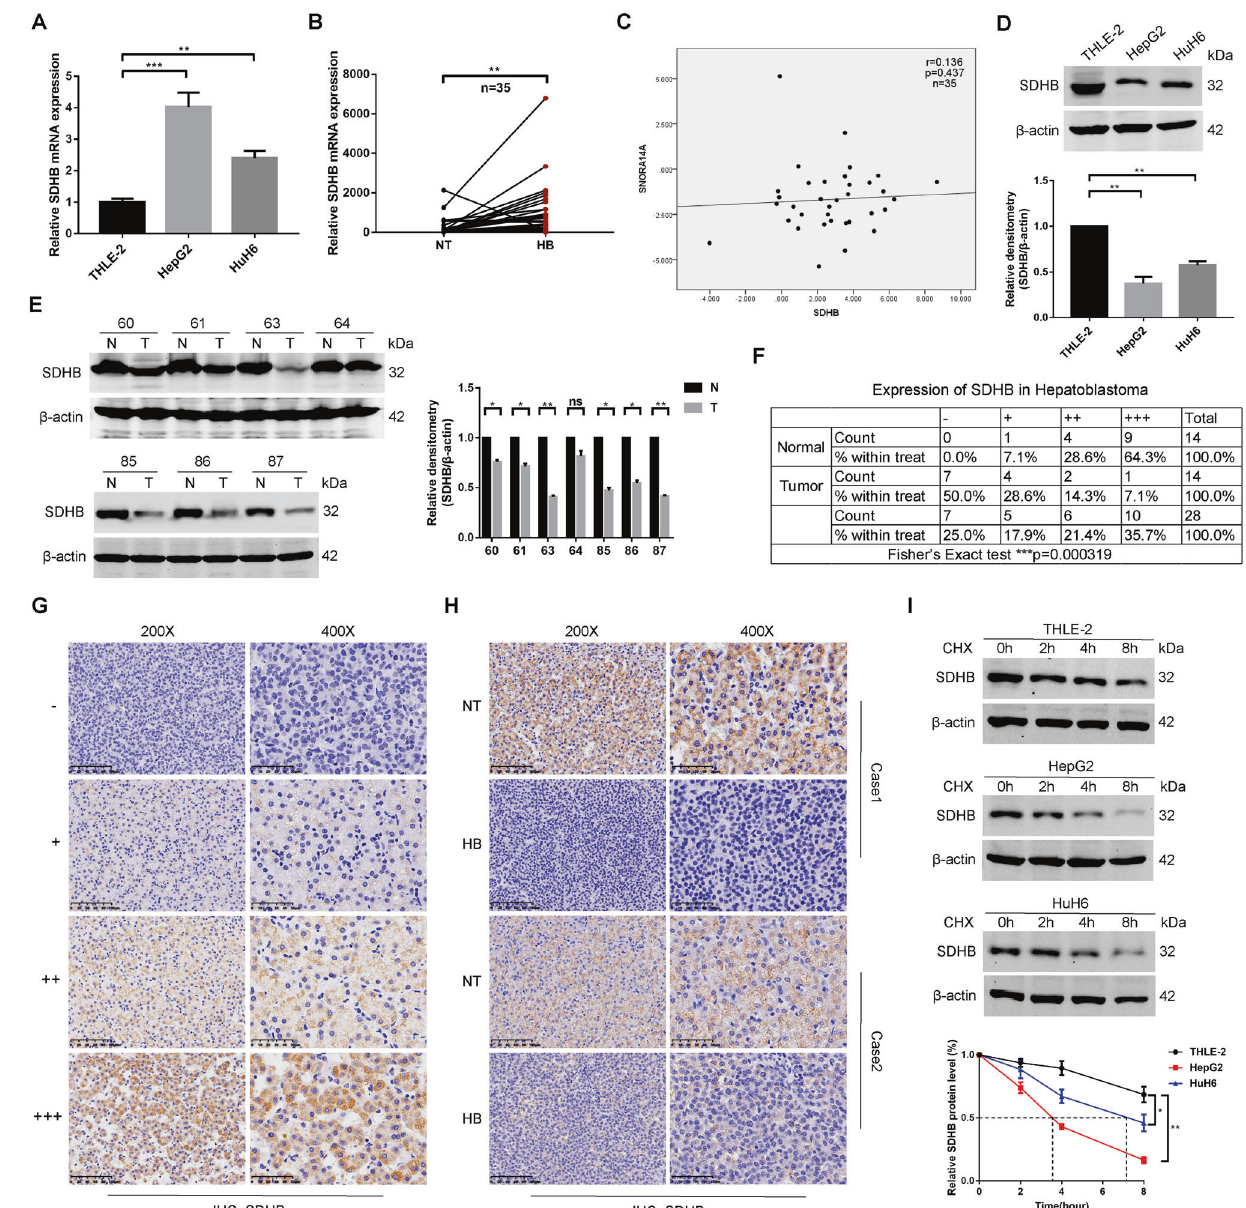
Fig. 6 Signi fi cant downregulation of SDHB protein levels in HB tissues and cells. A , B Relative mRNA levels of SDHB in cells ( A ) or 35 pairs of HB and NT tissues ( B ) were measured by qRT ‒ PCR. C Spearman rank correlation analysis of SNORA14A and SDHB expression levels. D , E SDHB protein levels in cells ( D ) or 7 pairs of HB and NT tissues ( E ) were measured by Western blotting assays. Relative densitometry was performed with ImageJ. F Fisher ’ s exact test was used to analyse SDHB protein levels in 14 pairs of HB and NT tissues. G , H Representative IHC images of SDHB staining in 14 pairs of HB and NT tissues. I SDHB protein levels in THLE-2, HepG2 and HuH6 cells were measured using Western blotting assays after treatment with 100 μ g/ml cycloheximide for the indicated times.